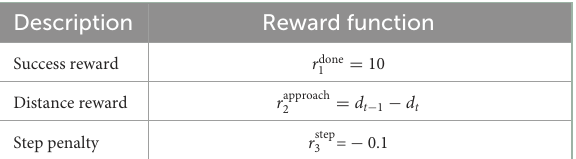
TABLE 2 The settings of the reward function. Description